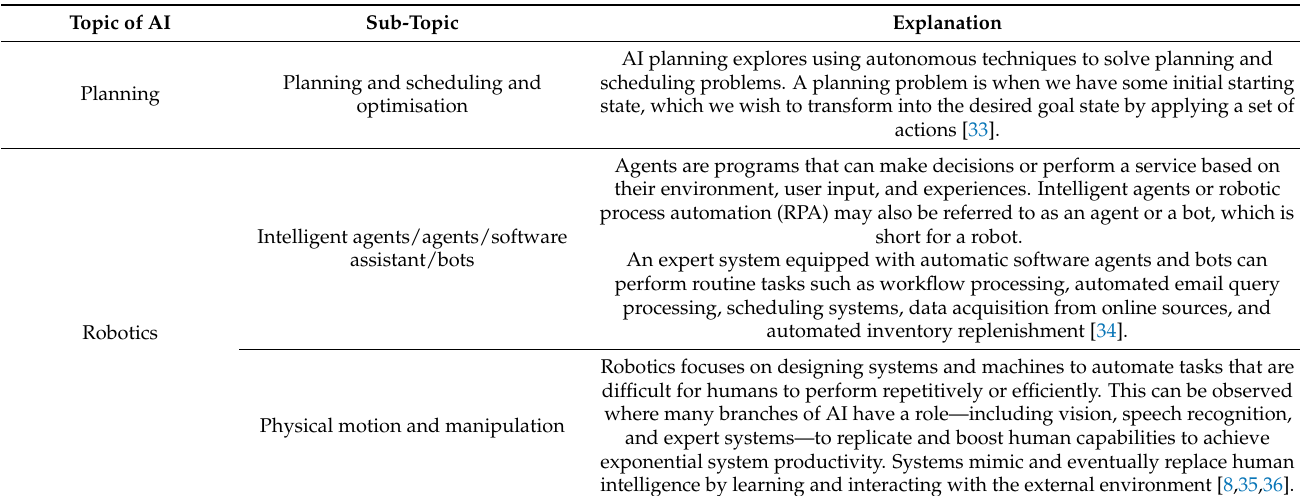
Table 2. Topics and sub-topics of